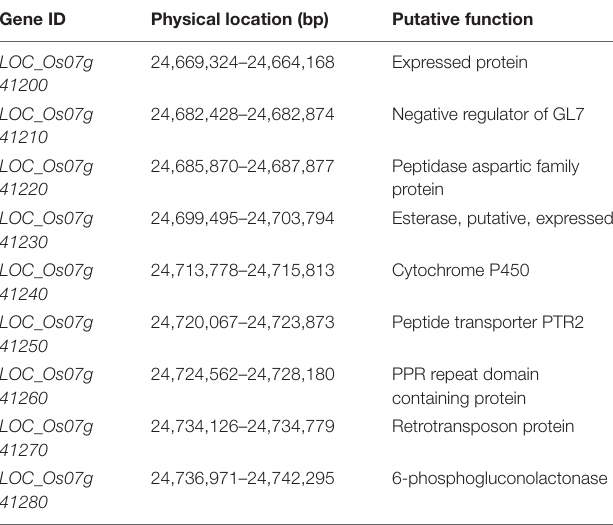
TABLE 5 | Annotation information of candidate genes identified within qPAA7 .